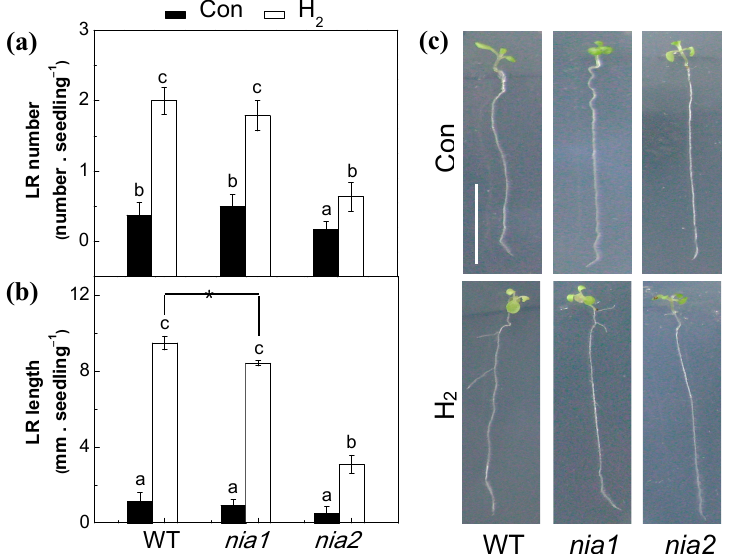
Figure 5. H 2 -induced cell cycle regulatory gene transcripts were sensitive to the removal of NO with its scavenger and NR inhibitor. Three-day-old tomato seedlings were incubated with solutions containing 200 nM NAA, 0.39 mM H 2 , 200 µM cPTIO, and 20 µM tungstate (Tg), alone or the combination treatments for 36 h. The transcripts of tomato CDKA1 , CYCD3;1 , and CYCA2;1 were analyzed using qPCR. Distilled water was used for the control (Con) treatment. Data are the means ± SE of three independent experiments with at least three replicates for each. Within each set of experiments, bars denoted by the same letter did not differ significantly at p < 0.05 level according to Duncan’s multiple range test.